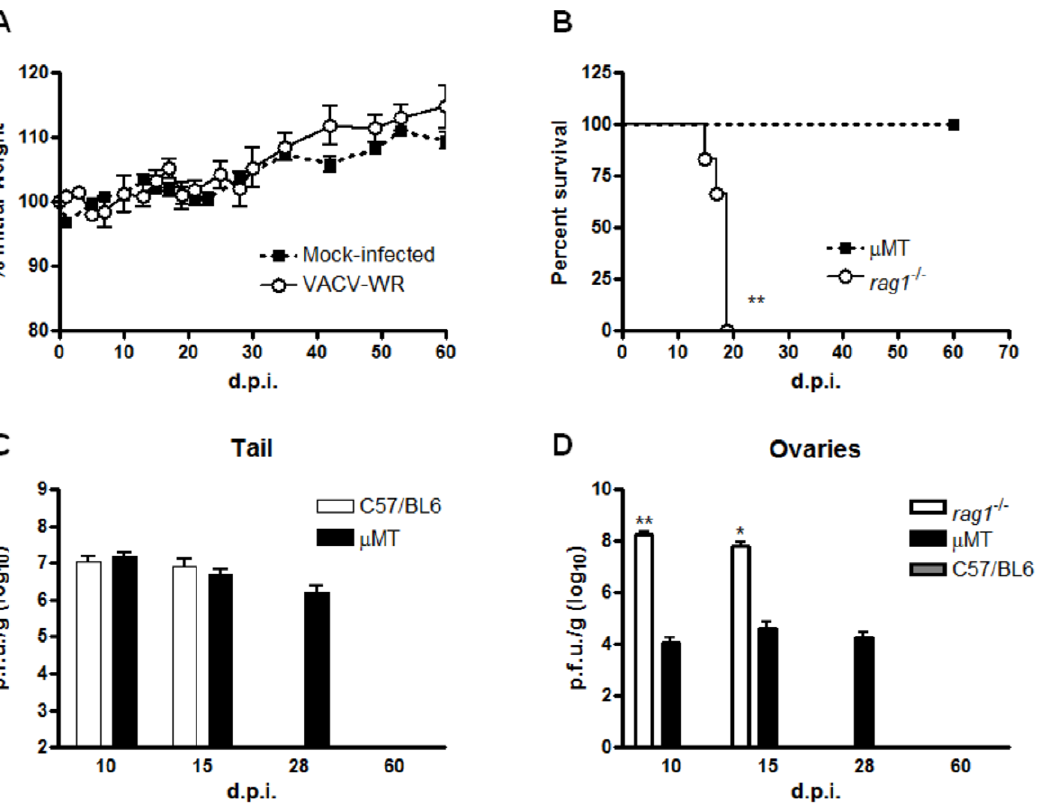
Figure 5. B-cell deficient mice did not show any signs of disseminated disease, but had delayed viral clearance. m MT mice ( n =6) were infected with 10 7 p.f.u. of VACV-WR by tail scarification. ( A ) Weight curve of m MT mice infected with VACV-WR or mock-infected. ( B ) The same animals were followed for 60 days to compute mean survival. ( C ) Viral titers were determined in tails of C57BL/6 and m MT mice at days 10, 15, 28 and 60 p.i. (* p , 0.05 and ** p , 0.01, t test). ( D ) Viral titers were determined in ovaries of m MT mice at days 10, 15, 28 and 60 p.i. and of Rag1 2 / 2 mice at days 10 and 15 p.i.(* p , 0.05 and ** p , 0.01, t test). Bars represent mean and standard error (SEM). Results shown are representative of two experiments.